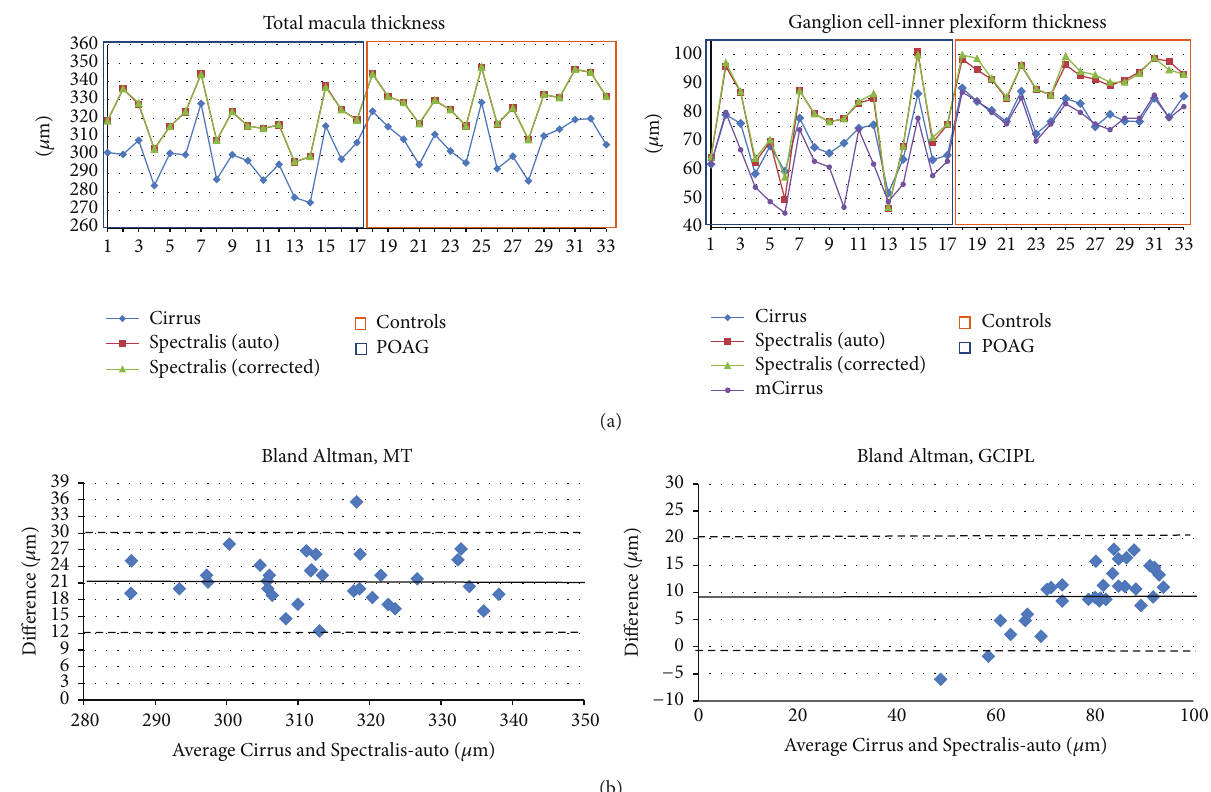
Average Cirrus and Spectralis-auto ( 𝜇 m) Figure 2: (a) This plot shows the measurements from both OCTs per patient: (left) total macula thickness; (right) ganglion cell-inner plexiform layer thickness. Comparison between these measurements allows visual appreciation of the difference per patient. (b) Respective Bland-Altman graphic representation comparing the difference between Cirrus and Spectralis MT (right) and GCIPL (left) to their mean. Auto: values using automatic segmentation in Spectralis; corrected: values after manual correction of retinal layer segmentation in Spectralis; mGCIPL: minimum GCIPL value calculated by Cirrus software. POAG: primary open angle glaucoma group; controls: control